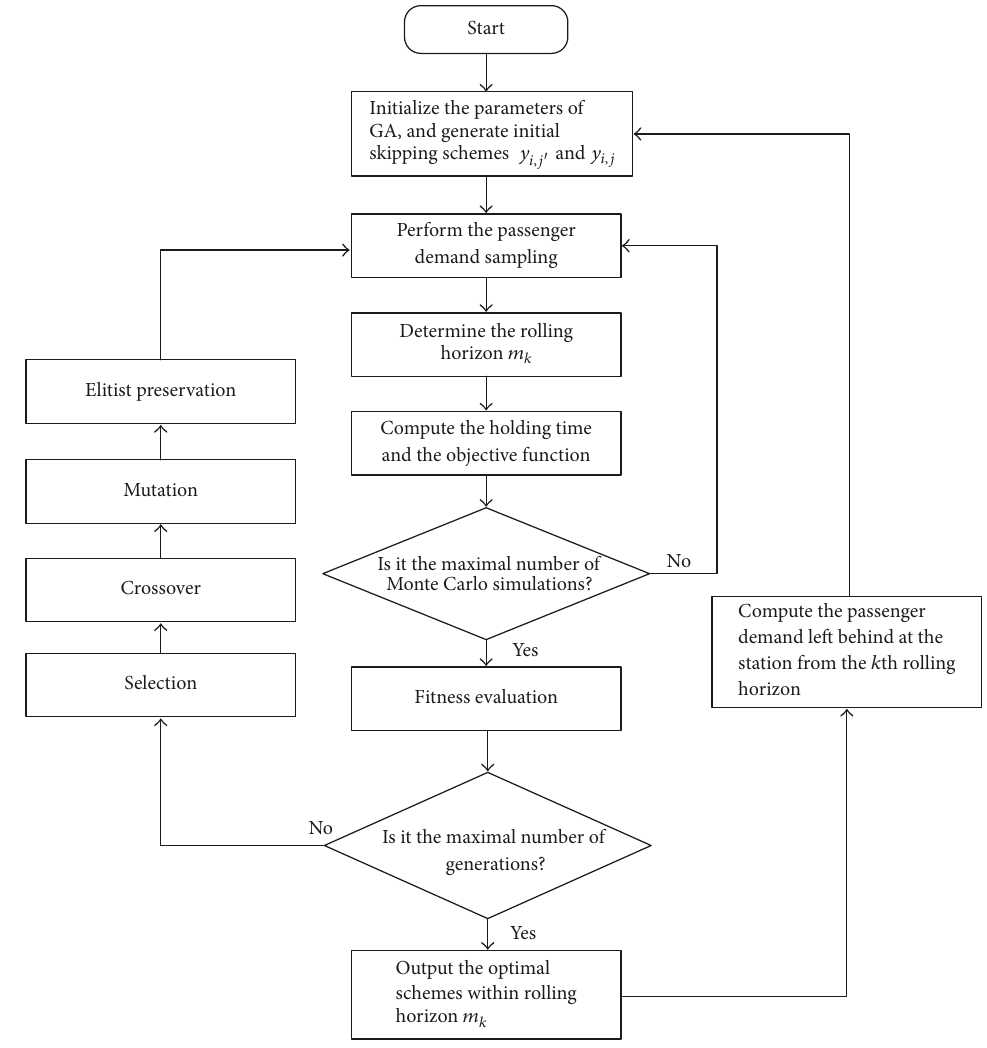
Figure 2: Solution method based on genetic